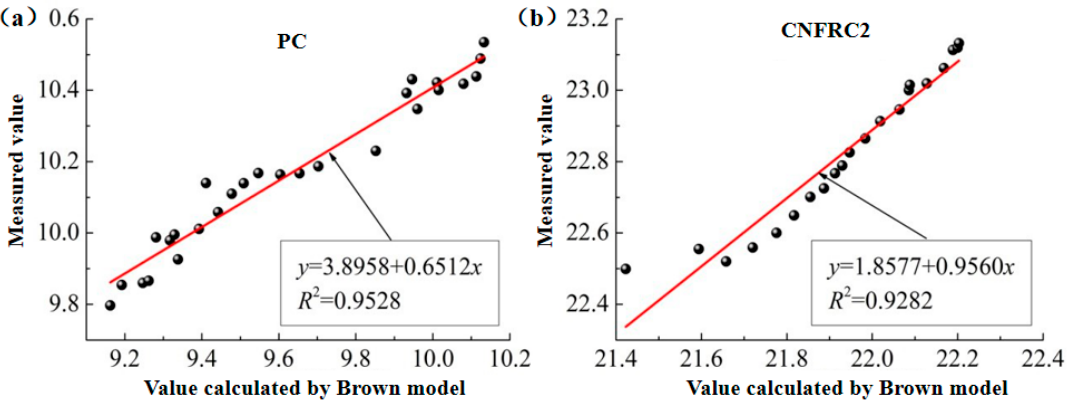
Figure 10. The fitting for relation between measured values and calculated values for ε , based on Brown model. ( a ) PC; ( b ) CNFRC2.